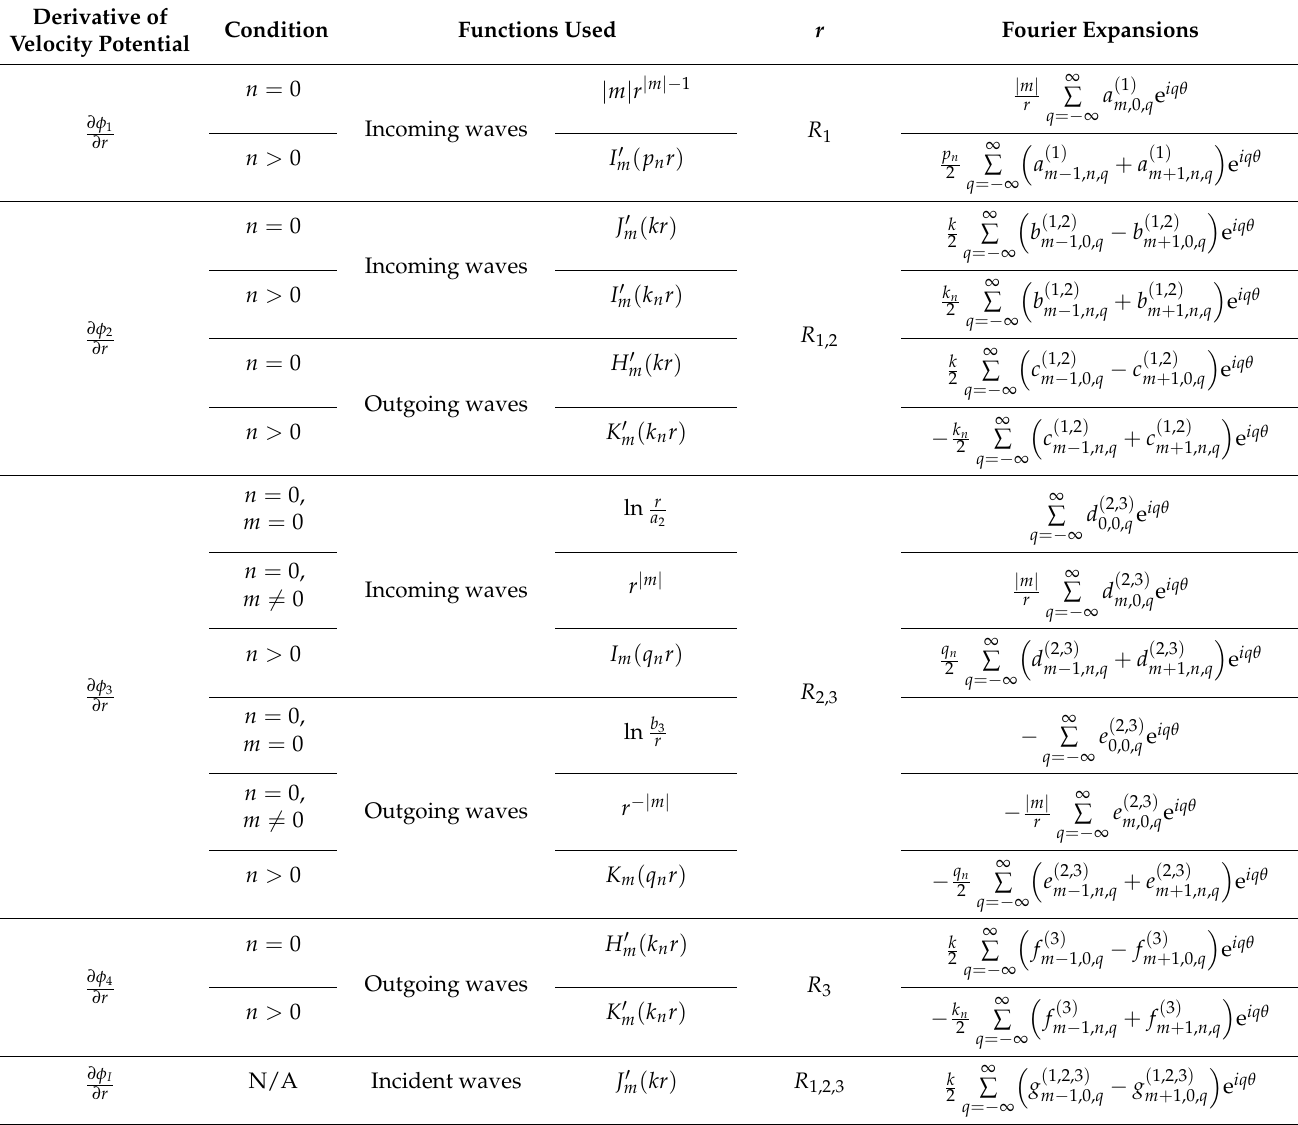
Table 3. Fourier expansions for the derivative of functions used in velocity